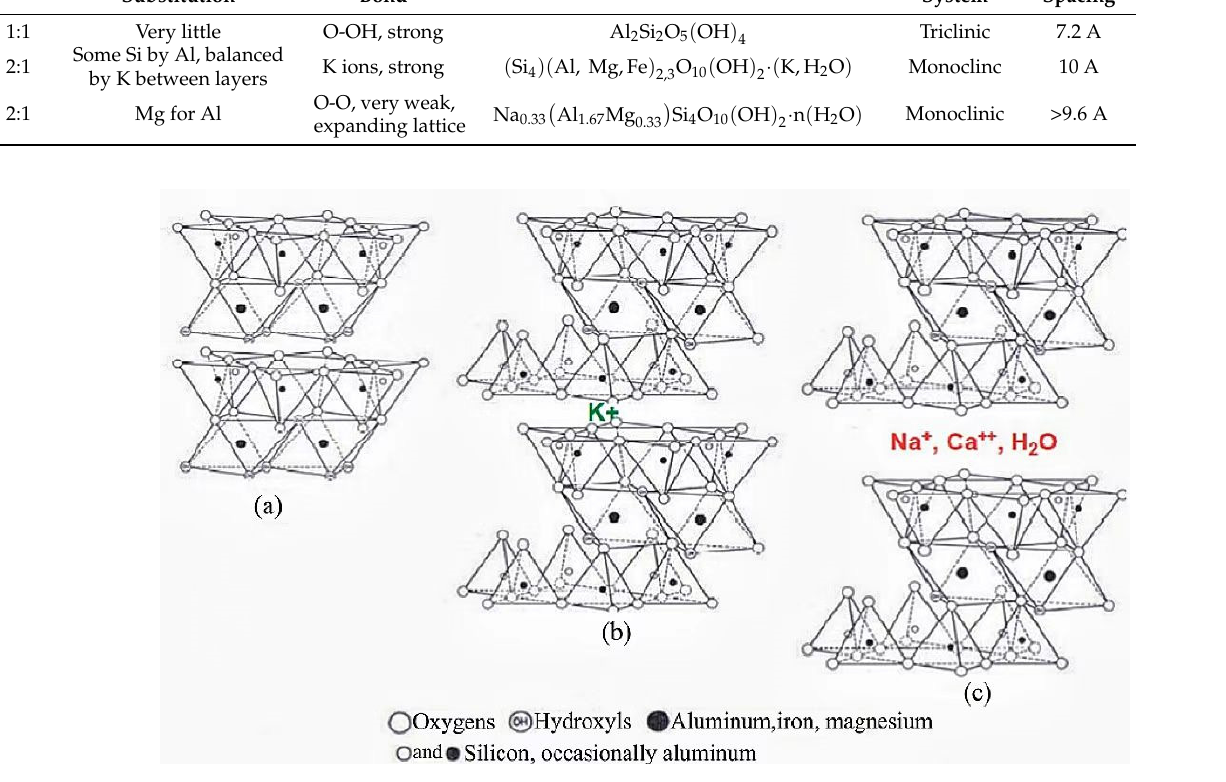
Table 2. Characteristics of kaolinite, illite, and montmorillonite. Reprinted with permission